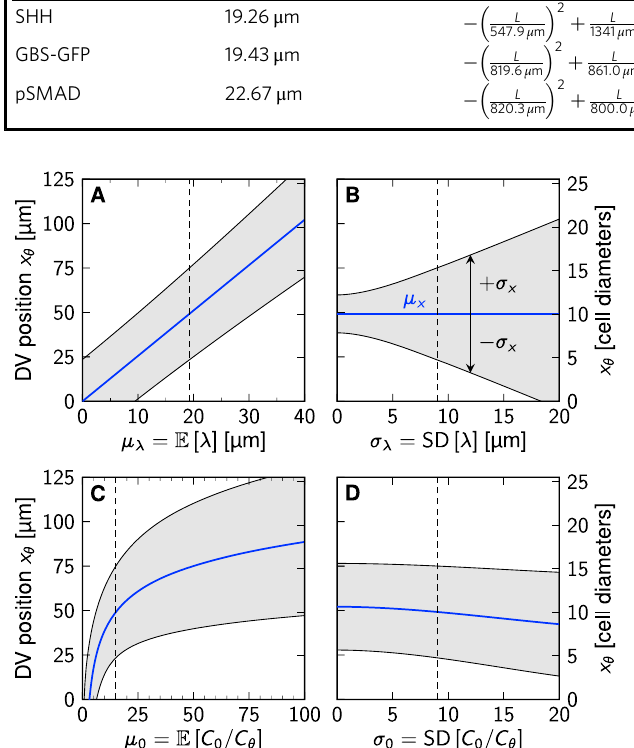
Fig. 5 Effect of concentration gradient parameters on domain boundary position and positional error. Equations (8) (blue) and (9) (gray) are plotted as a function of the mean gradient length ( A ), its standard deviation ( B ), the mean relative amplitude ( C ), and its standard deviation ( D ). Each panel shows the variation of one parameter, with the other three fi xed at measured early SHH values in mouse: μ λ = 19.26 μ m, σ λ = 9 μ m, μ 0 = 15, σ = 9 (indicated by dashed 0